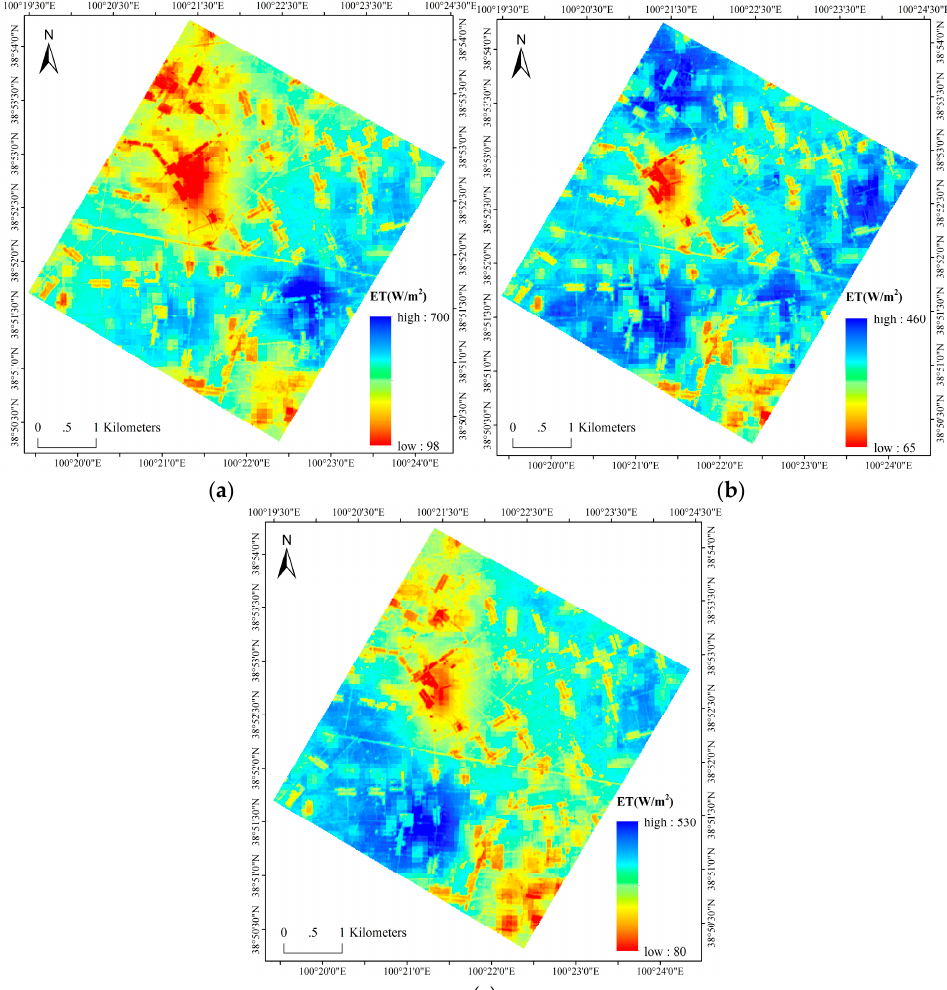
Figure 3. ET estimated by the SEB-A method on: 10 July 2012 ( a ); 11 August 2012 ( b ); and 27 August 2012 ( c ).